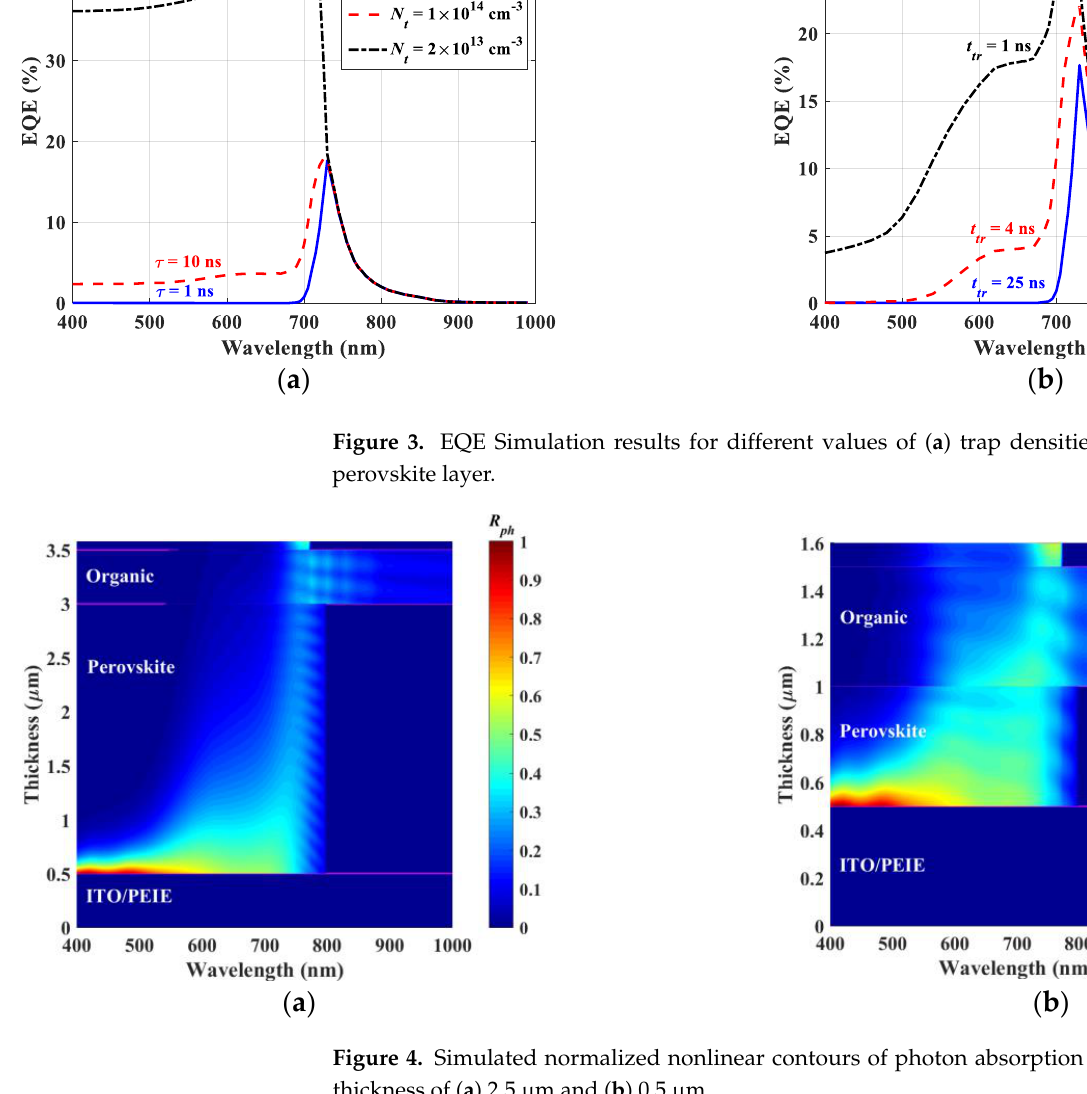
Figure 4. Simulated normalized nonlinear contours of photon absorption rate with a perovskite thickness of ( a ) 2.5 μm and ( b ) 0.5 μm.